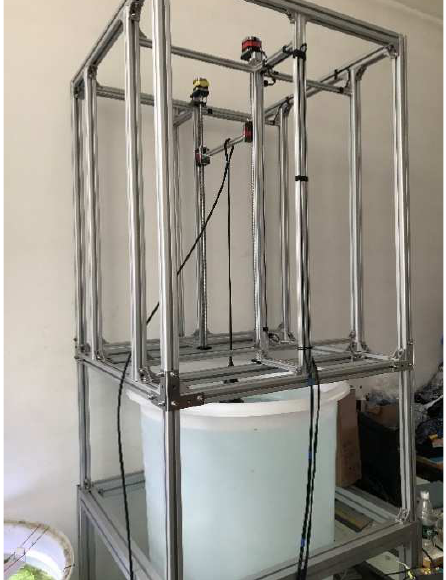
Figure 6. Longitudinal-ultrasonic-transducer error-calibration-test platform with a height of 1500 mm.